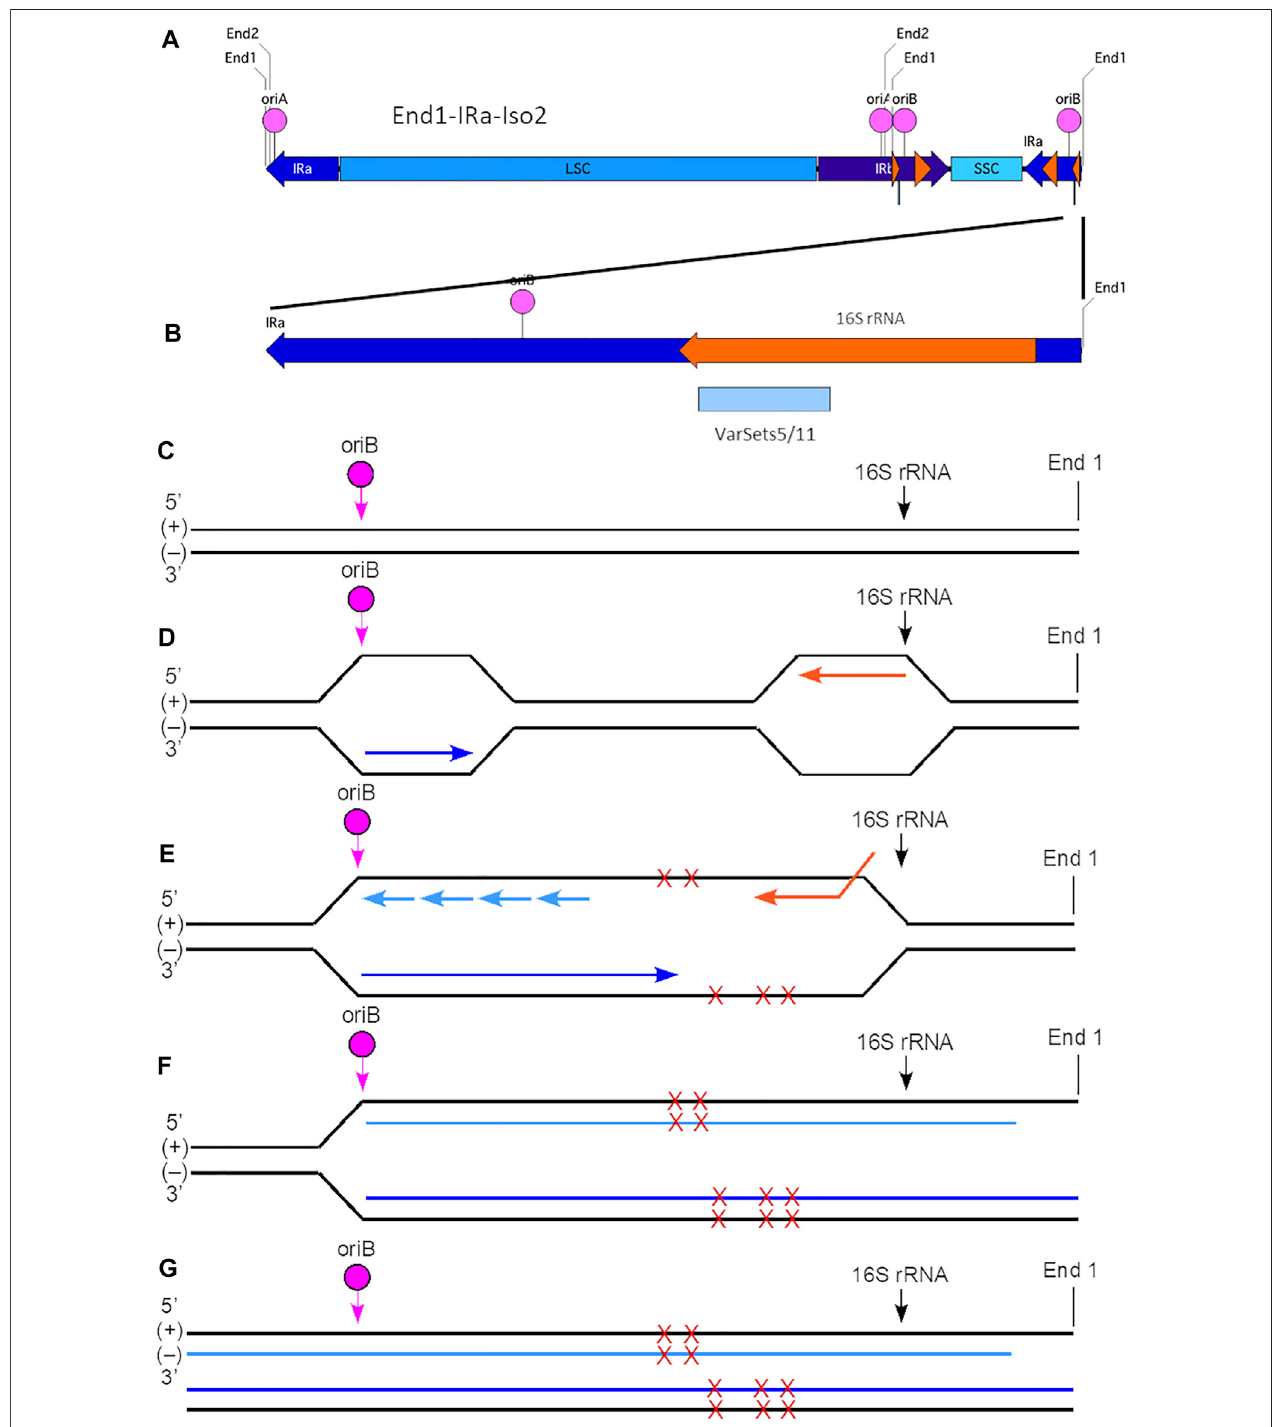
FIGURE5| ModelforgenerationofplastidptDNAvariantscausedbyhead-onreplication-transcription con fl ict. (A) TheplastidDNAmolecular isomerusedforthis model isEnd1-IRa-Iso2(see Supplementary Figure S2 ).Inthis isoform,the right-end region iscomprised ofaportion ofIRa (nt 117640-127764)thatcontainsoriB(nt 125441-125563),16SrRNAgene(nt126089-127579;codingon( − )strand),andwithEnd1terminus(nt127764).ThevariantCluster2(VarSets5/11;ntrange126175- 126724) is found within the 16S rRNA genic region of IRa. The nucleotide (nt) numbering corresponds to the maize plastid reference genome. The small orange arrowhead indicates the location of the 16S rRNA gene, and large orange arrowhead the location of the 23S rRNA gene. (B) Expanded view of the right-end region of isomerEnd1-IRa-Iso2,whichspansatotalof3,387 nts(nt124377-127764).TheClustertworegionincludes84variantswhichspanatotalof549